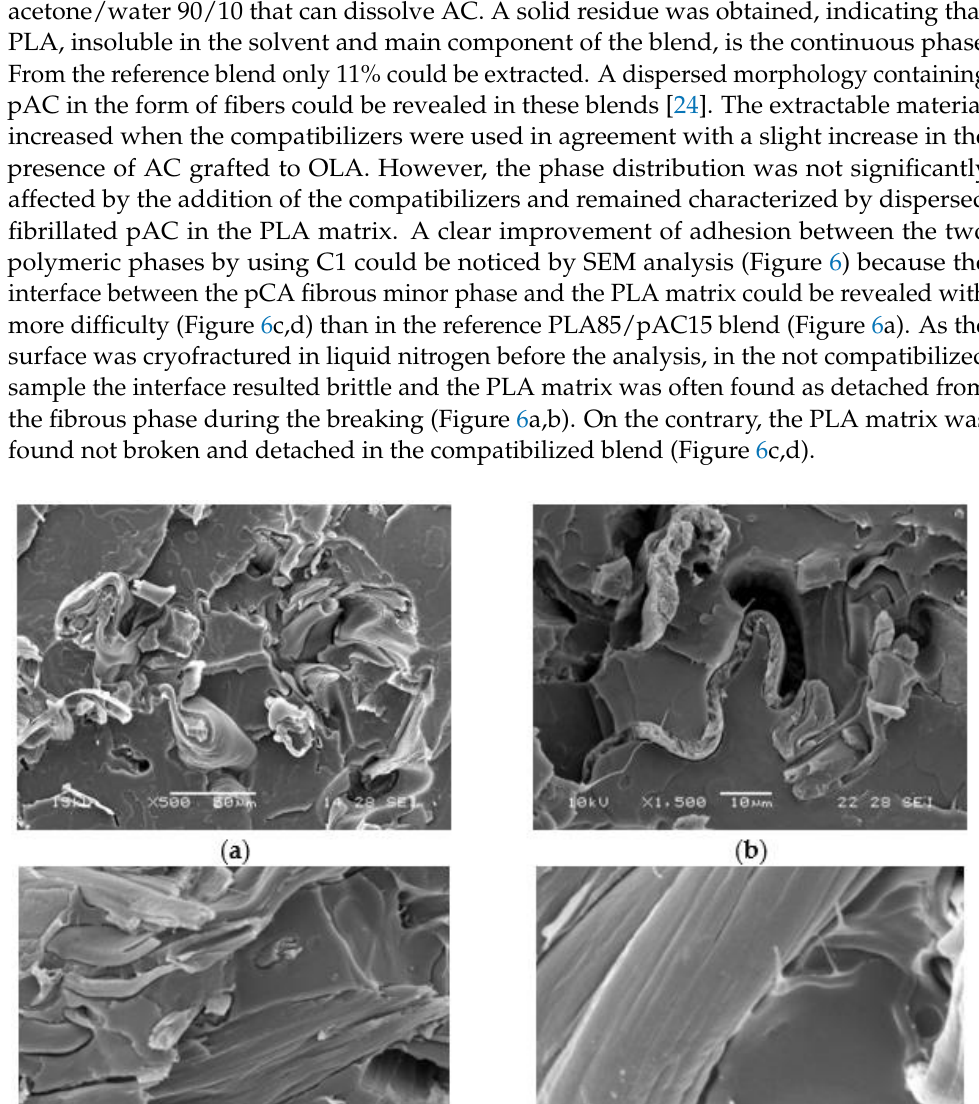
Table 2. Mechanical and impact properties of the PLA85/pAC15 blends compounded with Clab1 and C1. Entry